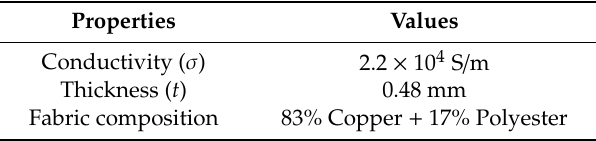
Table 1. The physical and electrical properties of fabricated e-textile.